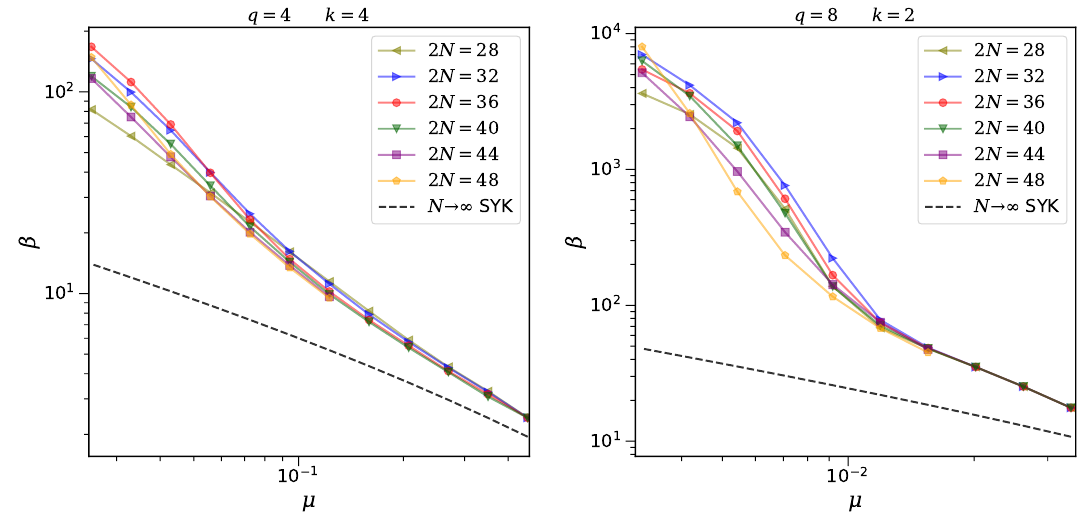
Figure 7. The inverse temperature β ( µ ) of the TFD state which maximizes the overlap |h TFD β | Ψ 0 i| . We set q = 4 , k = 4 (Left) and q = 8 , k = 2 (Right), and performed an average over 50 disorder realizations. The dashed line corresponds to the analytical formula (4.12) valid in the large N and large q